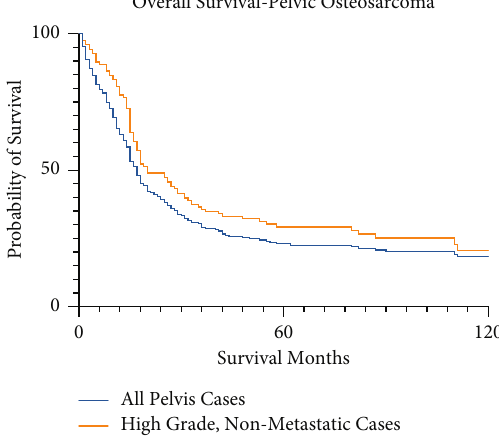
Figure 3: Kaplan–Meier survival curve for all pelvic osteosarcoma patients in this SEER cohort.